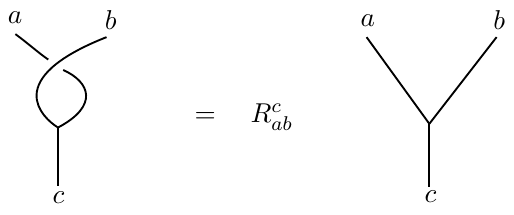
Figure 3 . Pictorial definition of the